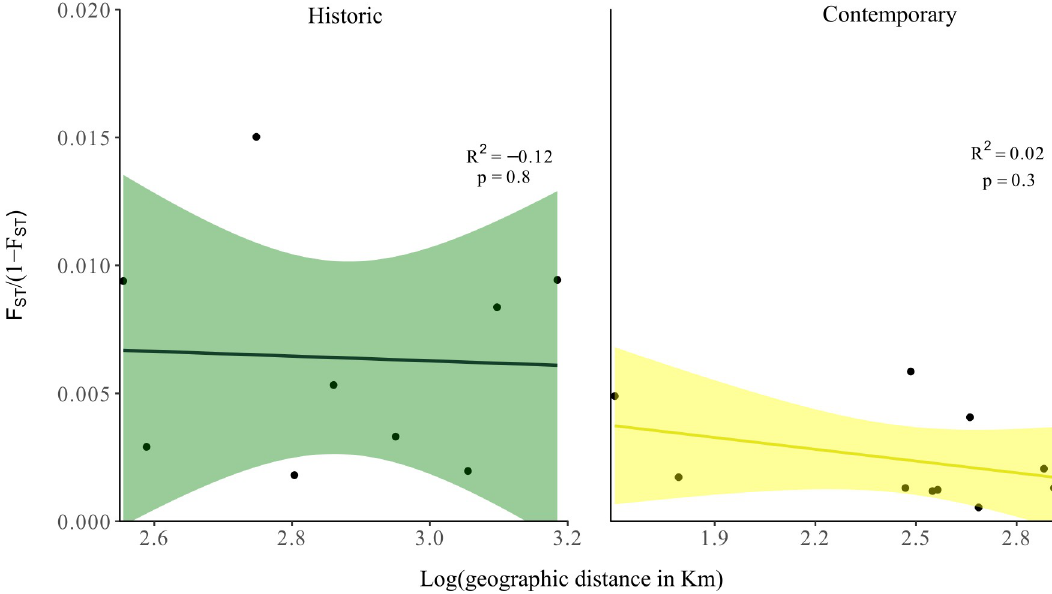
Fig 4. Standardized effect of geographic distance on a-priori population-level genetic differentiation in historic and contemporary (recent and current) regent honeyeater samples.